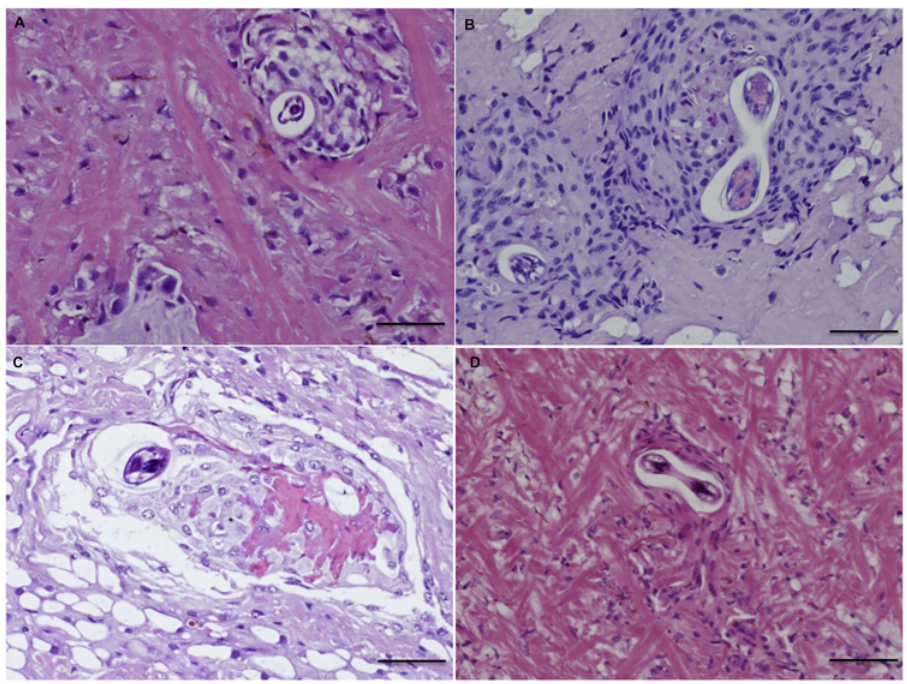
Fig 3. Histopathology: Inflammatory response to A . abstrusus in the H . aspersa . Cell-poor granuloma formation with vacuolated amebocytes at 3dpi. (A); cell-rich granuloma formation at 9 dpi (B); small necrotic granuloma at 15 dpi (C); fibroblast-like reaction at 27 dpi (D) (scale bar = 50 μ m; H&E).